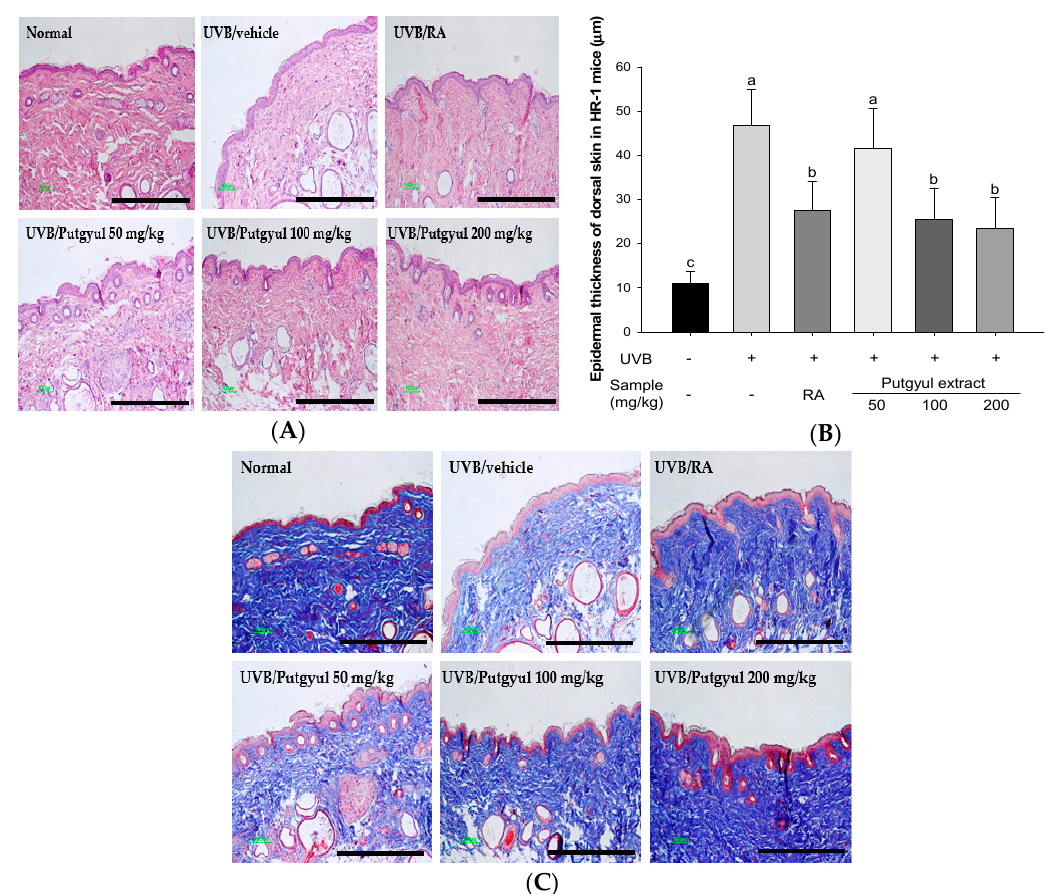
Figure 4. Histological analyses of hematoxylin and eosin (H&E) and collagen degradation in hairless mouse skin. ( A ) H&E stained sections; ( B ) Epidermal thickness; ( C ) Collagen fibers were stained using Masson’s trichrome stain. Scale bar is 400 µm. a–c All values are presented as mean ± standard deviation. Bars with different letters indicate statistically significant differences among the groups at p < 0.05 by one-way ANOVA.